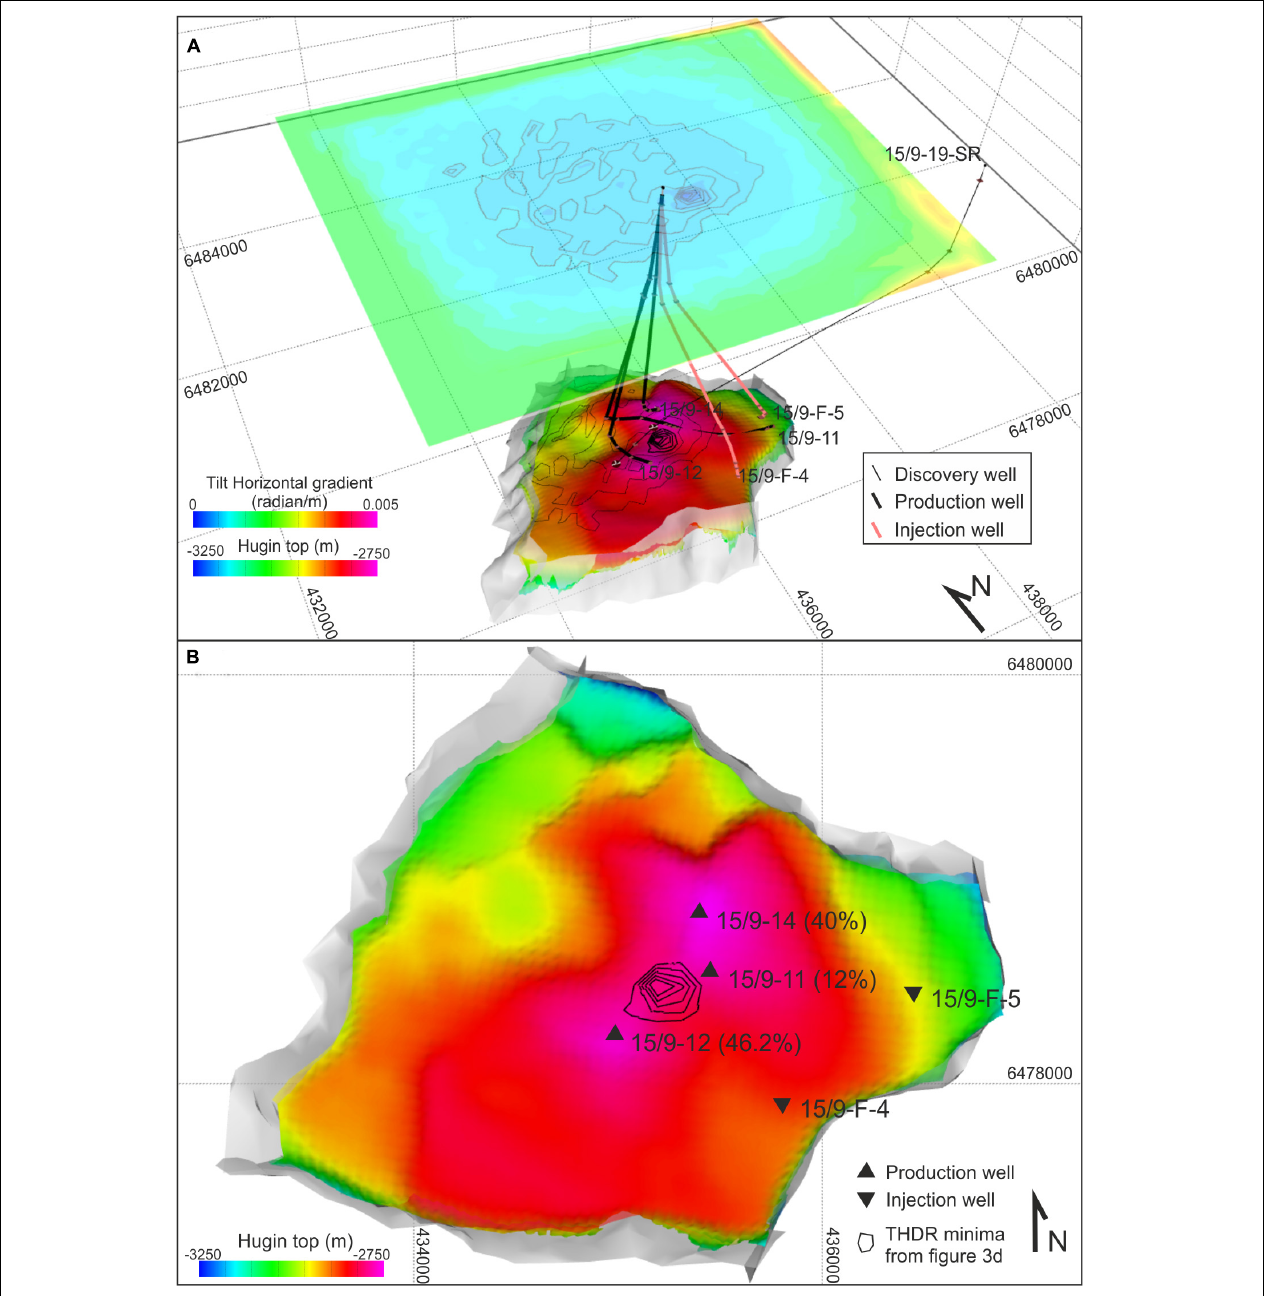
FIGURE 4 | (A) Three-dimensional view of the THDR over the Volve field. The contoured values (thin black lines) were projected to the top Hugin at depth for spatial comparison with reservoir geometry and wells locations. (B) Map view of the reservoir top (i.e., top of the Hugin formation) compared with THDR values < 0.6 milliradians m − 1 and locations of the contacts between well tracks and top Hugin (triangles). Percentage values within parentheses represent the production over total mass balance achieved by each well. Contour lines are spaced 0.1 milliradians m − 1 . Horizontal and vertical scales are the same as in Figure 1 .